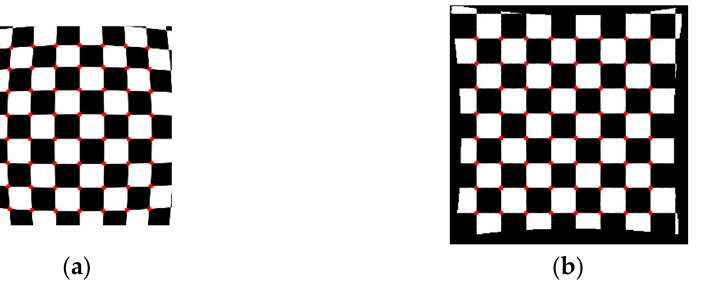
Figure 7. Analyzed results of checkerboard image, where the red points represent the corners. ( a ) Distorted checkerboard image with distortion parameter λ = − 1 × 10 − 6 and distortion center (289,273) ; ( b ) Corrected image.